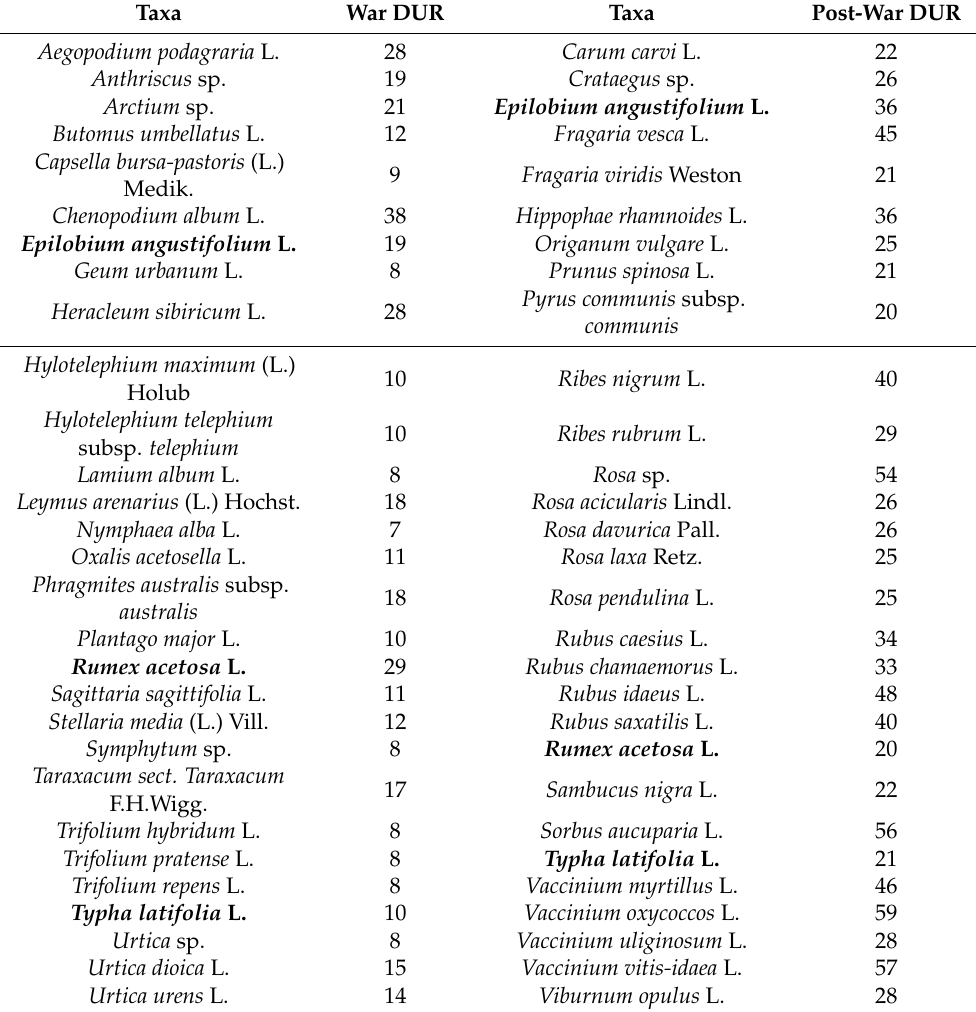
Table 2. The 29 most popular taxa in the two research